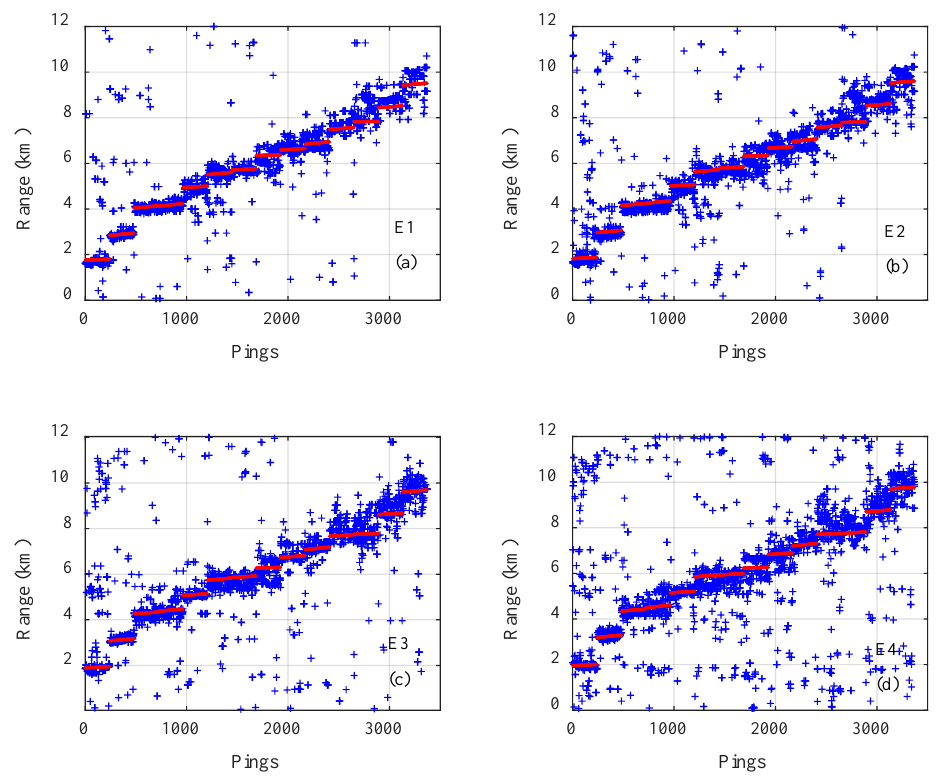
Figure 5. The true range (red) and the estimated range of the classification convolutional neural network (blue) for all 3371 samples on track 1 with emission energy of ( a ) E1, ( b ) E2, ( c ) E3, ( d ) E4.